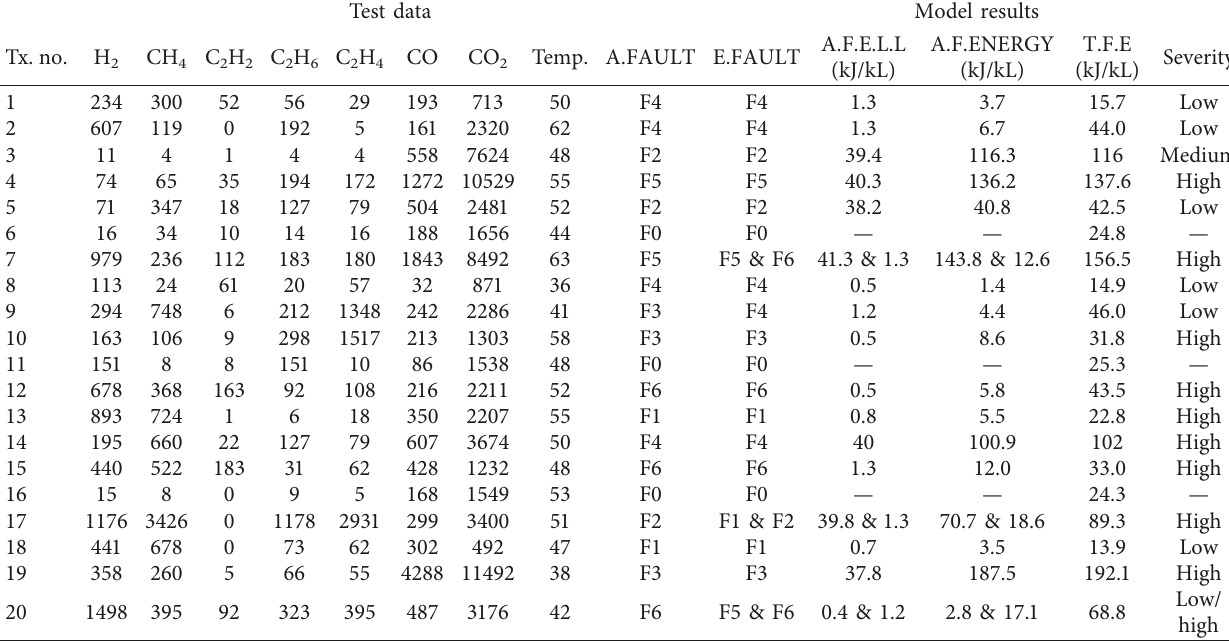
Table 5: Test data and model results.